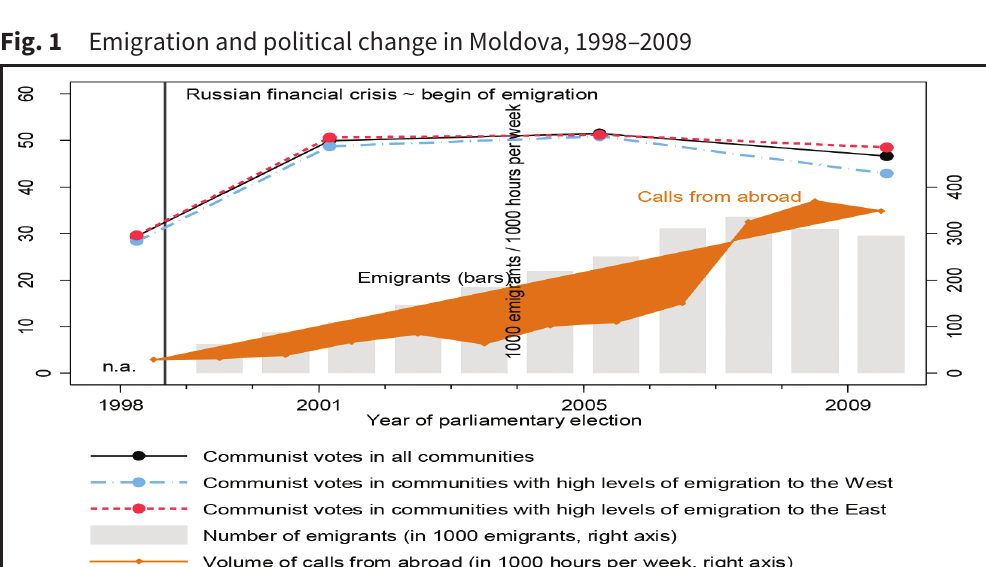
Source : Barsbai et al.